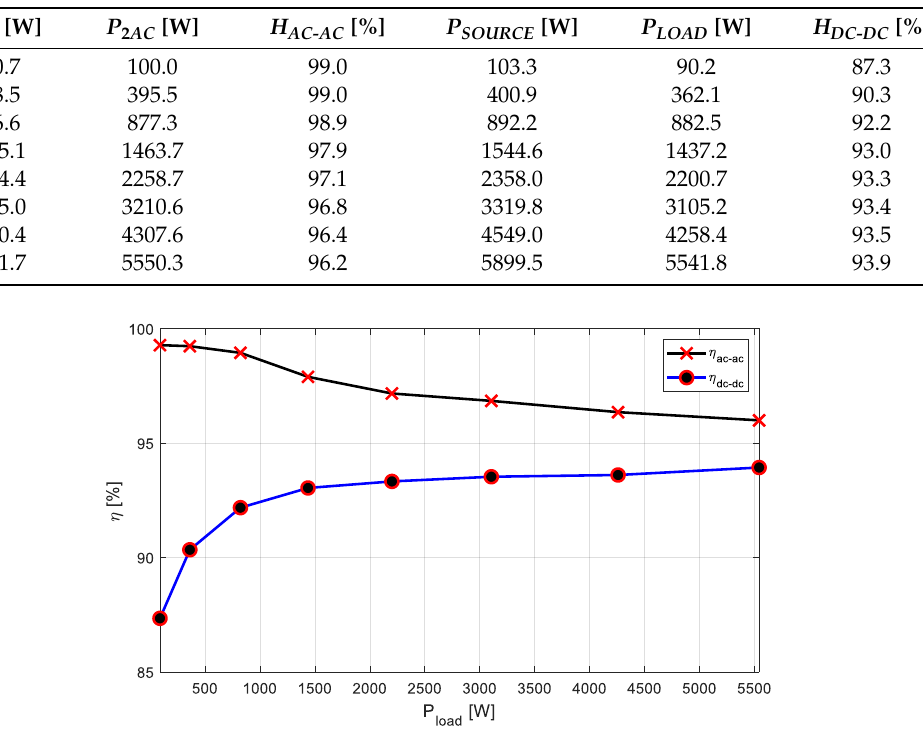
Table 1. Measured experimental data.